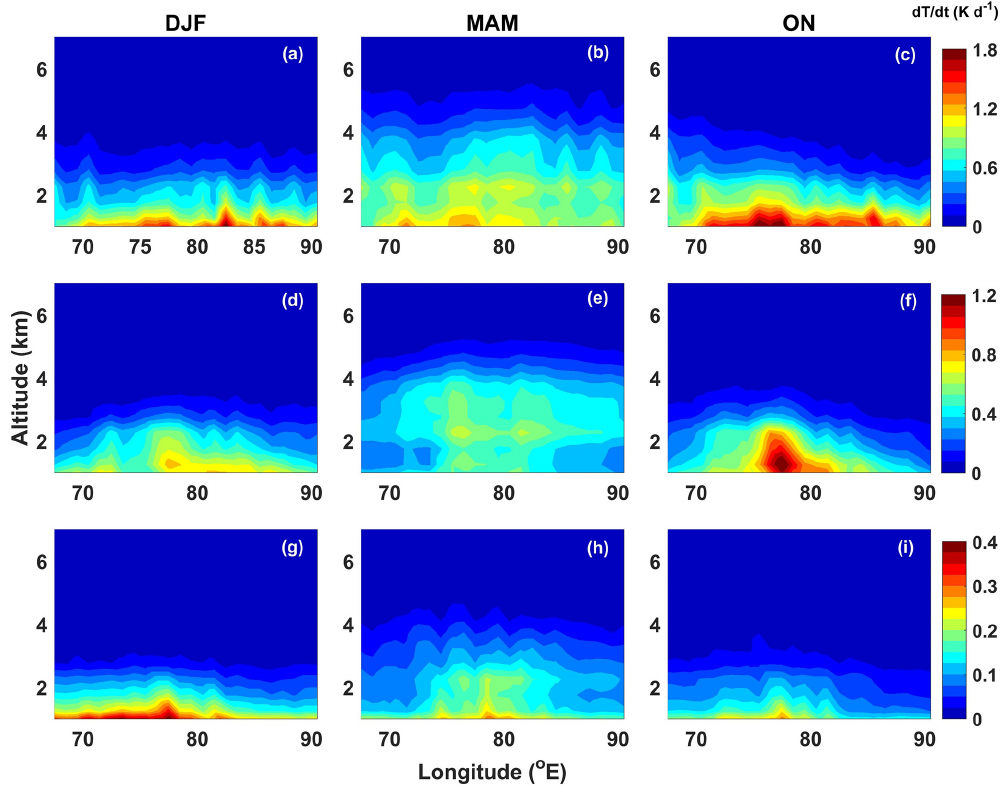
Figure 6. Zonal variation in aerosol-induced atmospheric heating rate profiles (d T / d t ) for SR1 (a, b, c) , SR2 (d, e, f) , and SR3 (g, h, i) sub-regions. Each column corresponds to a particular season, as marked above